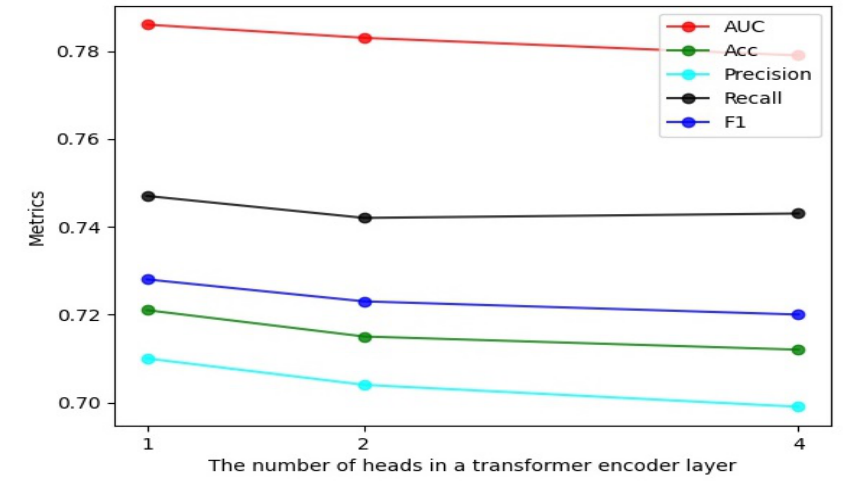
Figure 7. Effect of the number of heads in a transformer encoder layer on the experiment with the Book-Crossing